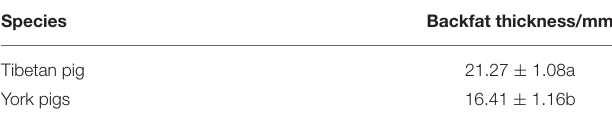
TABLE 1 | Comparison of backfat thickness